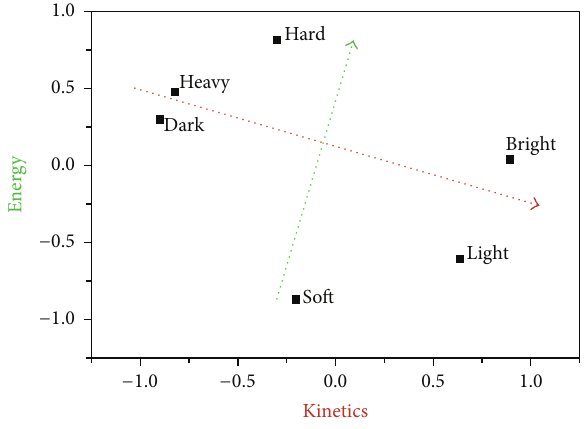
Figure 1: Kinetics-Energy space, as mid-level representation of expressive intentions.